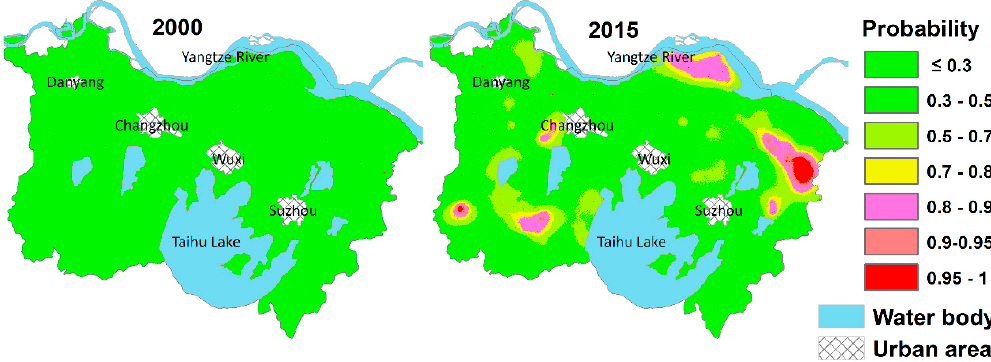
Figure 7. Probability maps of soil Cd (Cadmium) concentrations exceeding the background value.